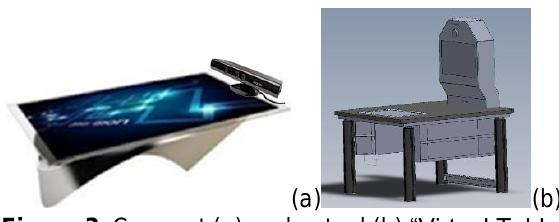
Figure 3. Concept (a) and actual (b) “Virtual